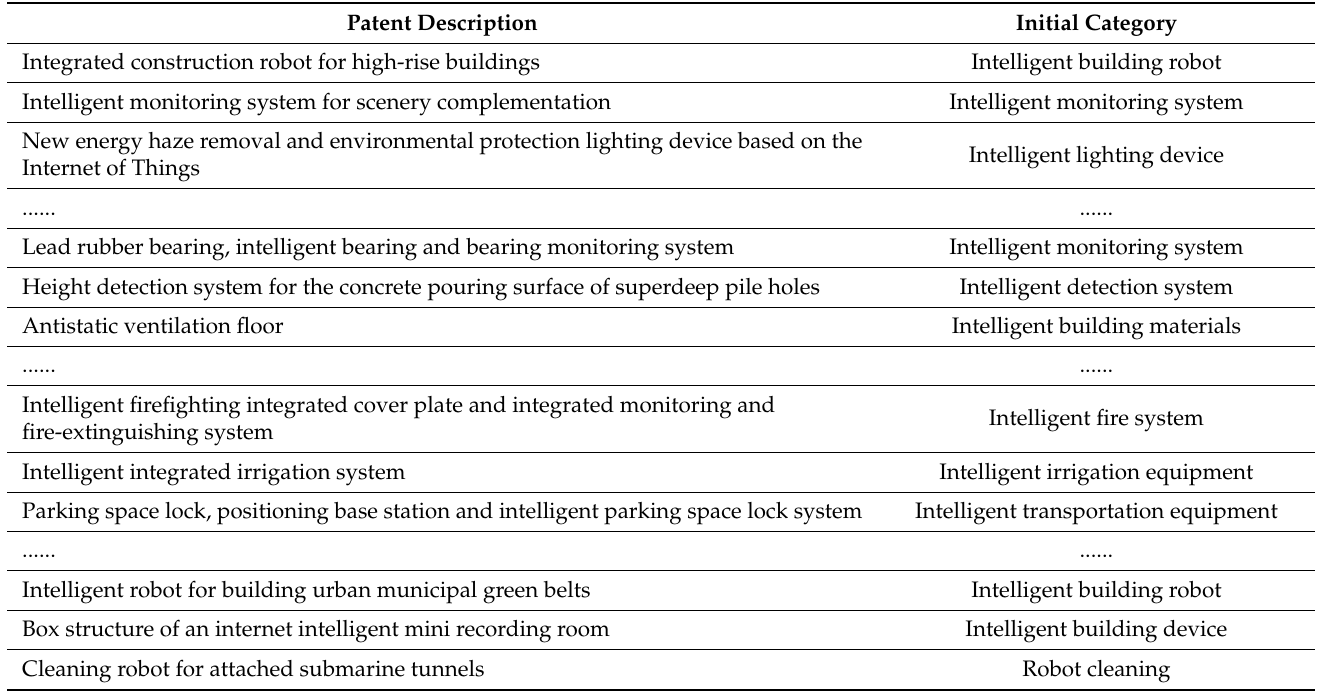
Table 2. Examples of open coding.